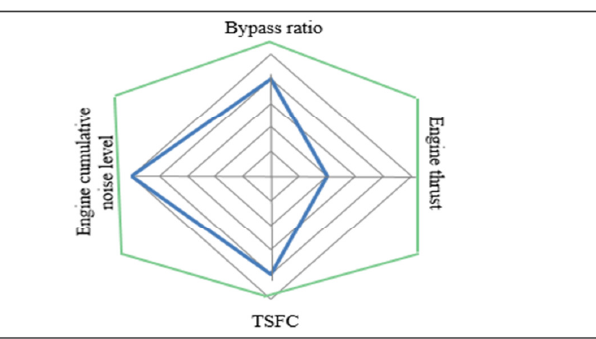
Fig. 5. Trent 768-60 optimum solution according to engine thrust force and engine cumulative noise level .